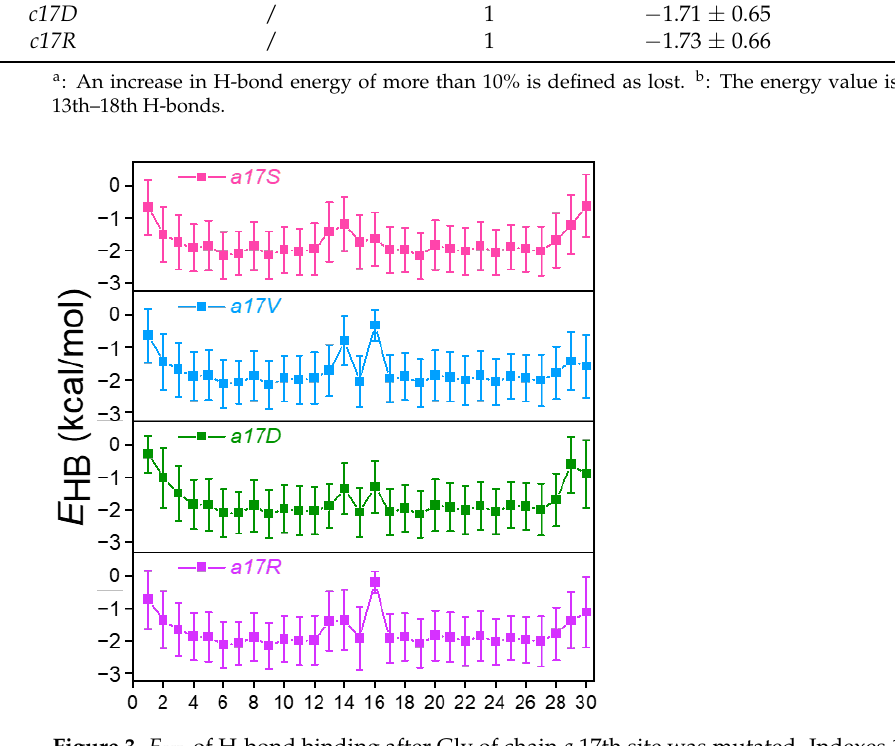
Figure 3. E HB of H-bond binding after Gly of chain a 17th site was mutated. Indexes 1–30 represent Figure 3 . E HB of H-bond binding after Gly of chain a 17th site was mutated. Indexes 1 – 30 represent the position of each H-bond in the the position of each H-bond in the collagen.